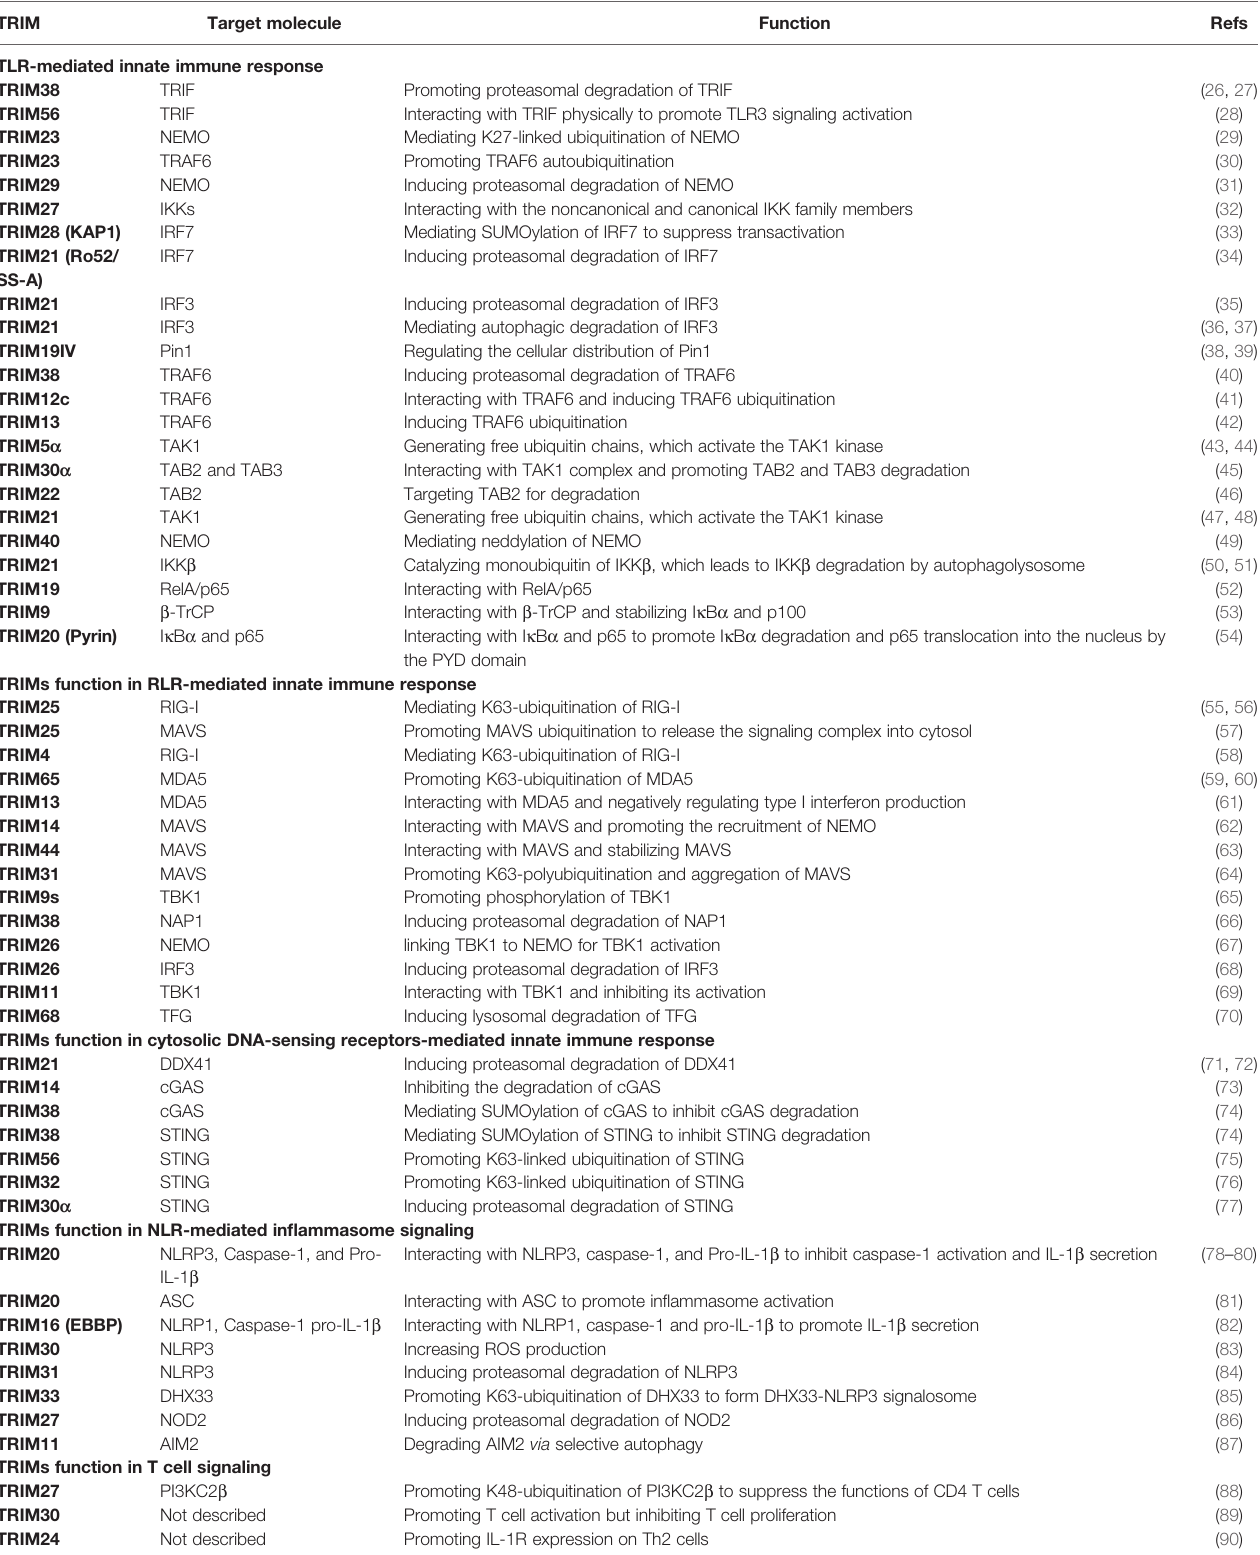
TABLE 1 | Regulation of immune responses by TRIM proteins and their regulatory